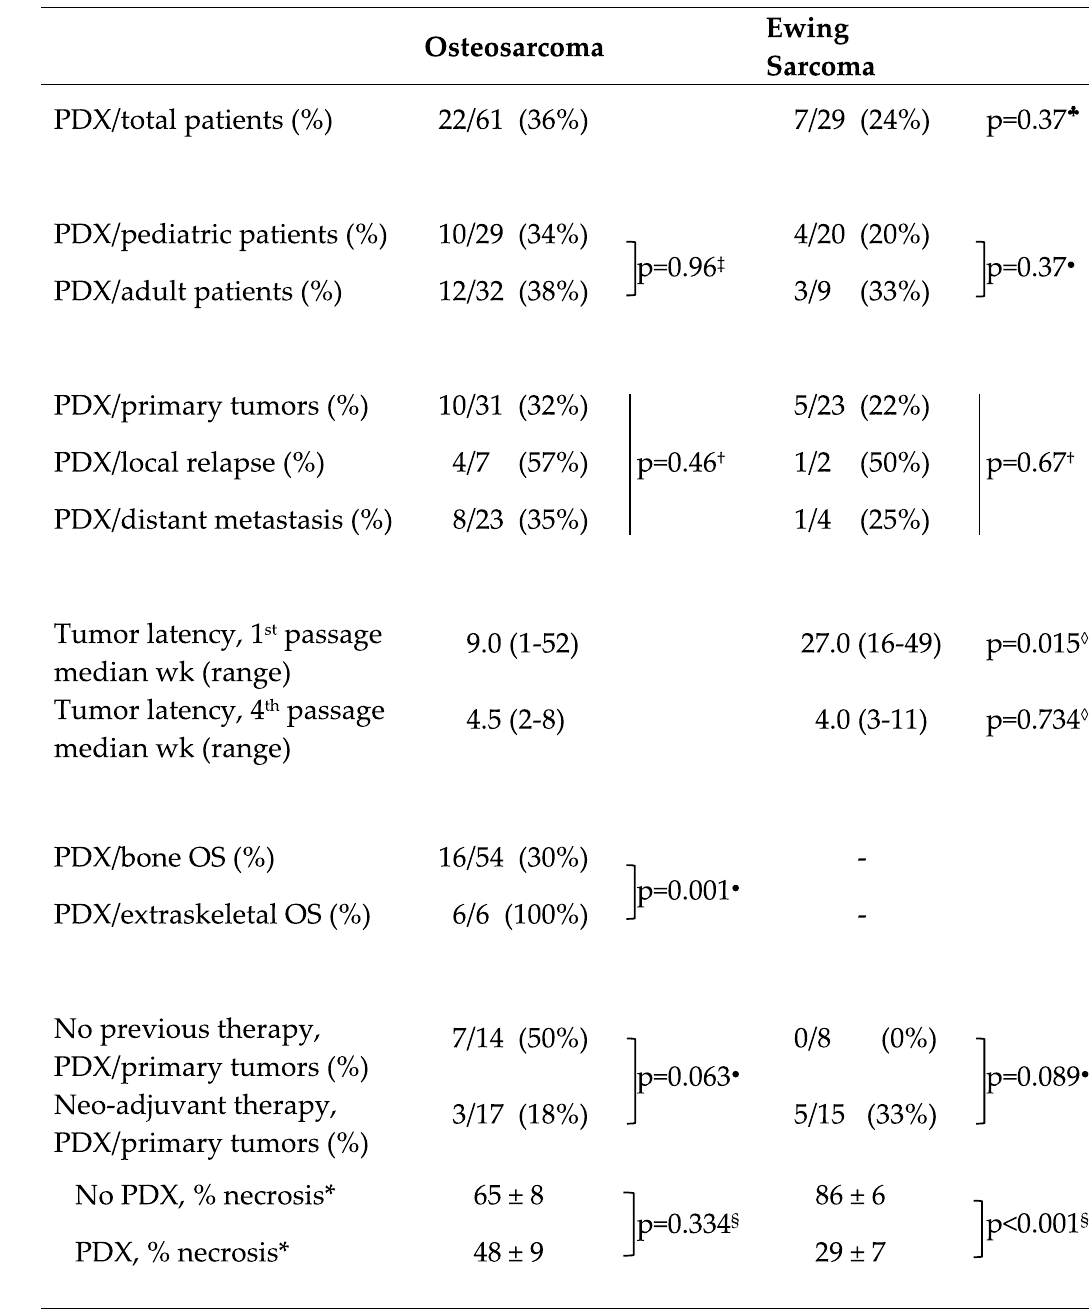
Table 1. Establishment of bone sarcoma PDX. ♣ OS vs EW, χ 2 with Yates’s correction. ‡ χ 2 , Yates’s correction.